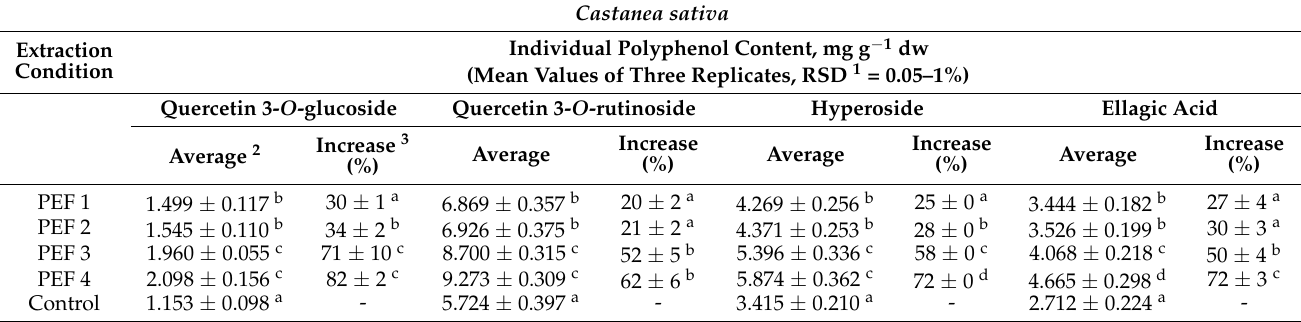
Table 4. Identified polyphenolic compounds of Castanea sativa (leaves) extracts. Castanea sativa Extraction